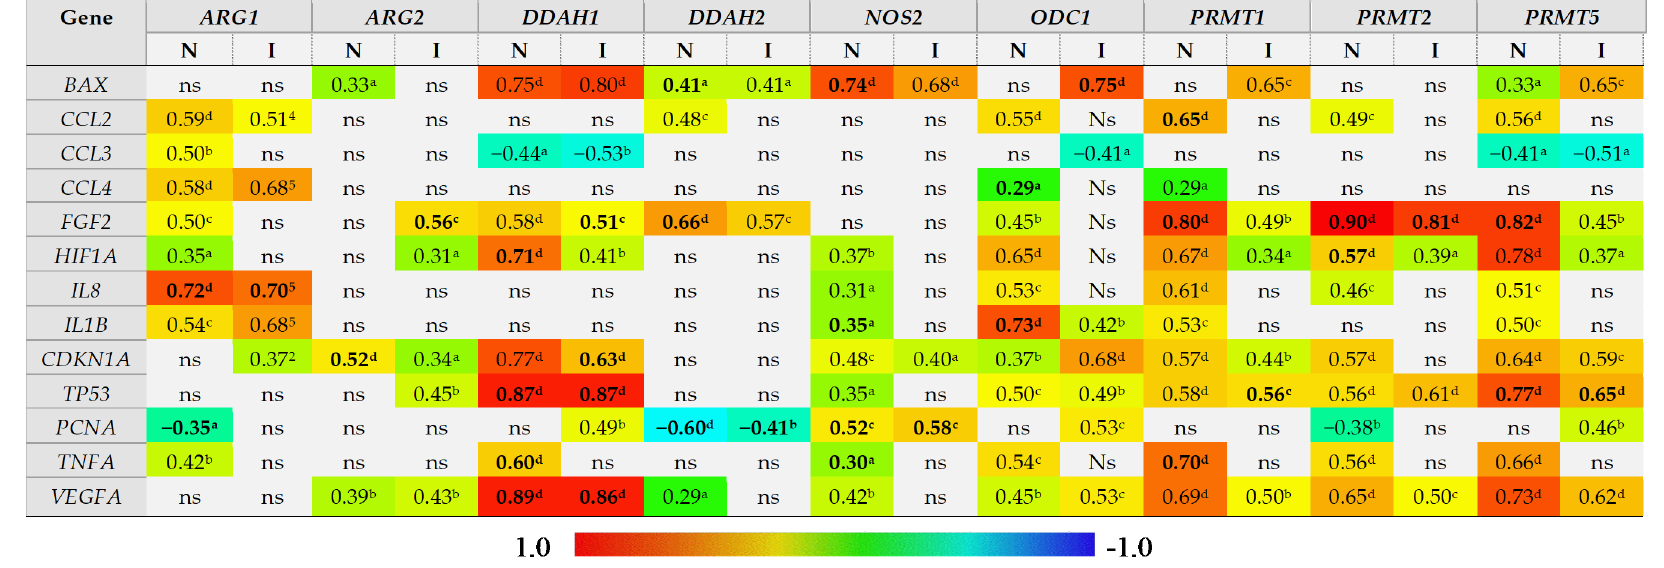
Figure 7. Correlogram of associations between the expression level of genes encoding L-arginine / NO pathway enzymes and genes encoding mediators of inflammation and angiogenesis and markers of proliferation, hypoxia, and cell cycle progression and apoptosis in inflamed and non-inflamed bowel tissue. An “inflamed” group includes samples of inflamed large and small bowel from patients with Crohn’s disease and inflamed large bowel from patients with ulcerative colitis, whereas a “non-inflamed” group includes samples of quiescent small and large bowel from patients with Crohn’s disease and normal small bowel from patients with ulcerative colitis. Results presented as correlation coe ffi cients r and analyzed on log-transformed data using Pearson’s correlation test separately for inflamed (I; n = 40) and non-inflamed ( N ; n = 50) bowel tissue; a p < 0.05; b p < 0.01; c p < 0.001; d p < 0.0001; ns, non-significant. Variables retained as independent predictors (a stepwise method of least squares multiple regression analysis) in non-inflamed or inflamed bowel tissue are written in bold. ARG, arginase; DDAH, dimethylarginine dimethylaminohydrolase, NOS, nitric oxide synthase; ODC, ornithine decarboxylase; PRMT, arginine N-methyltransferase; BAX, Bcl-2-associated X protein; CCL2–4, chemokine (C-C motif) ligand 2–4; FGF2, basic fibroblast growth factor 2; HIF1A, hypoxia-inducible factor 1 α , IL, interleukin; CDKN1A, cyclin-dependent kinase inhibitor 1; TP53, tumor protein p53; PCNA, proliferating cell nuclear antigen; TNFA, tumor necrosis factor α ; VEGFA, vascular endothelial growth factor A.